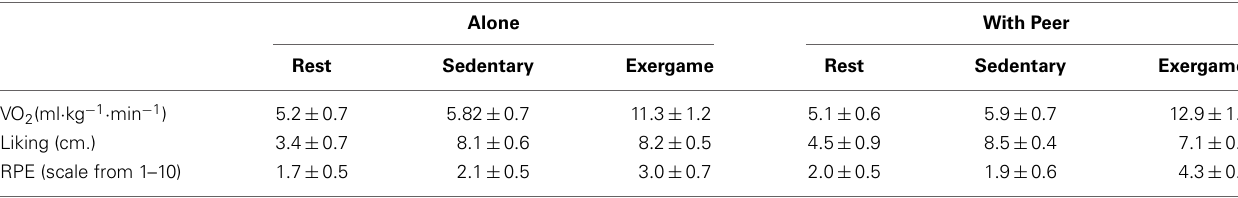
Table 2 | Omnibus table of means for VO 2 , liking, and RPE. Alone With Peer